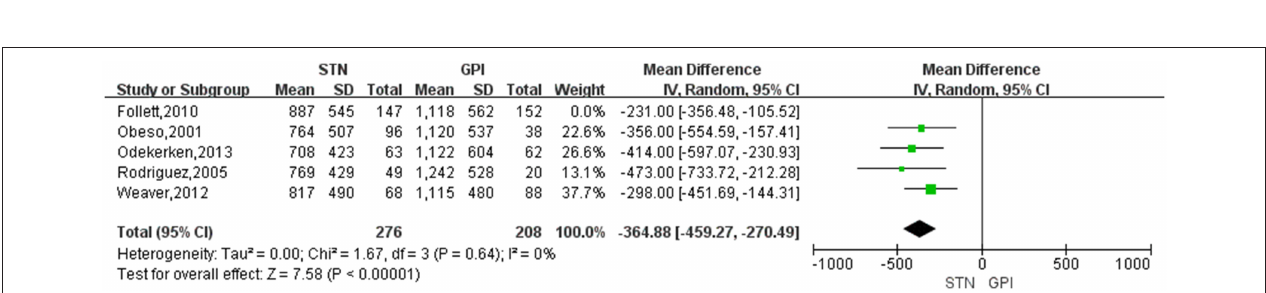
Frontiers in Neurology | www.frontiersin.org